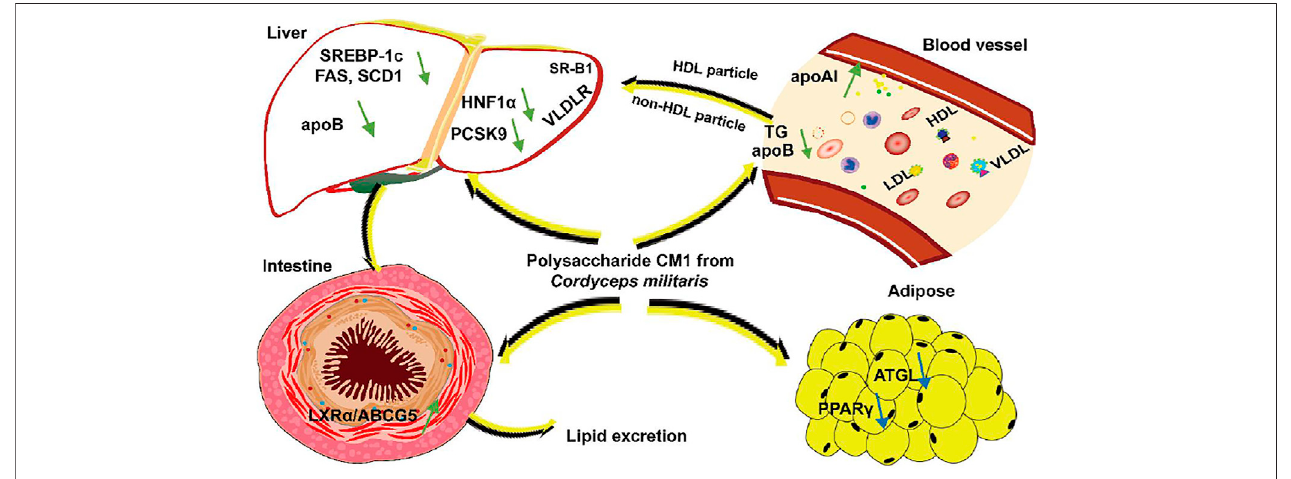
FIGURE 10 | The proposed mechanisms of action of CM1 in